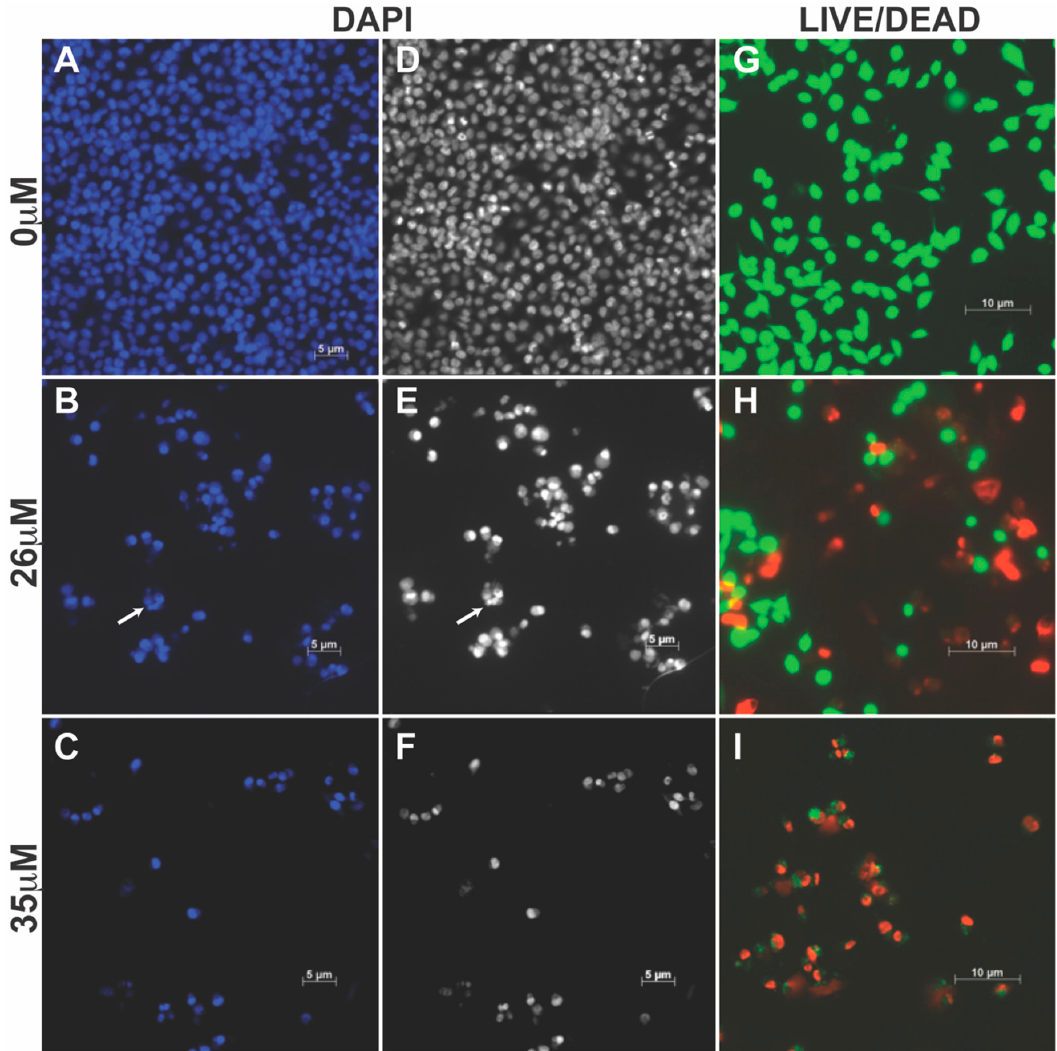
Figure 3. Characteristic apoptotic morphological changes in MiaPaca-2 cells after 24 h treatment with BisP4 : ( A , D , G ) 0 µM; ( B , E , H ) 26 µM ( C , F , I ) 35 µM. The DAPI stain ( A – F ) revealed morphological changes indicative of apoptosis in a dose-dependent manner. BisP4 treated MiaPaca-2 cells display distinct apoptotic bodies (arrow), as a result of increased DAPI staining of fragmented nuclear bodies. At the higher concentration (35 µM) the cells show an intense fluorescence corresponding to